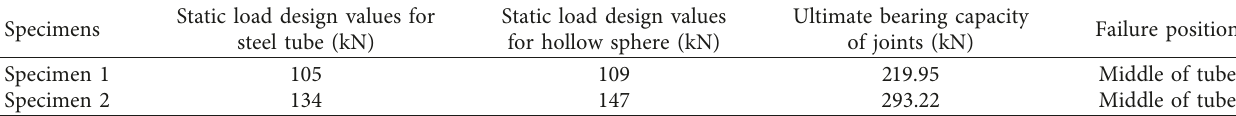
Figure 7: Static load-induced failure mode. (a) Specimen 1. (b) Specimen 2. Table 4: The design values and ultimate bearing capacity values of